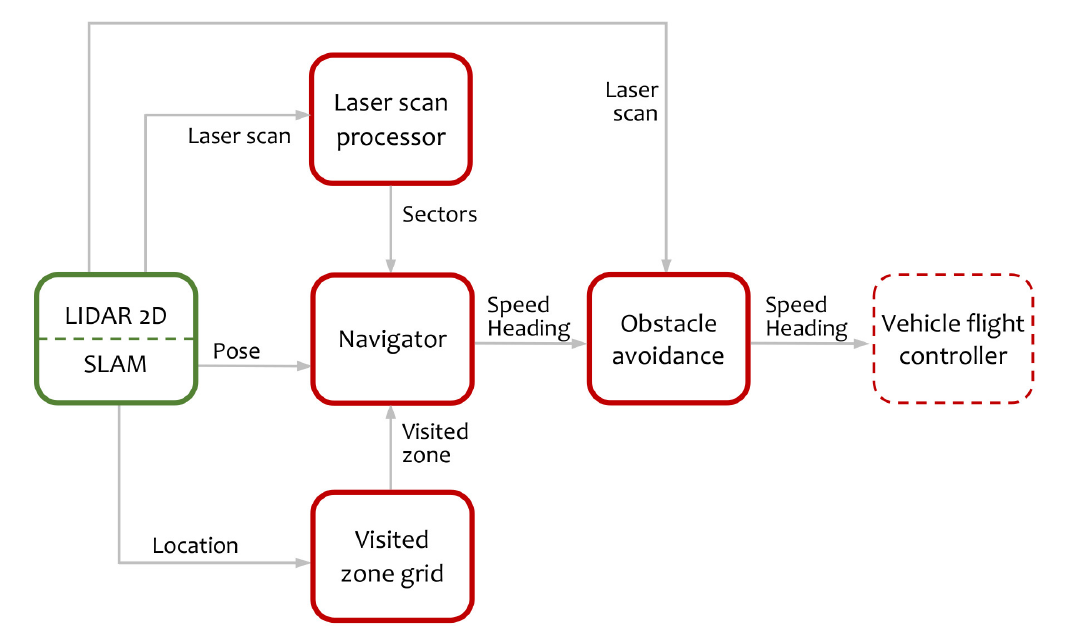
Figure 1. Top-level information flow diagram. In red are represented the algorithm components, in green the sensor, and in dashed line the vehicle flight